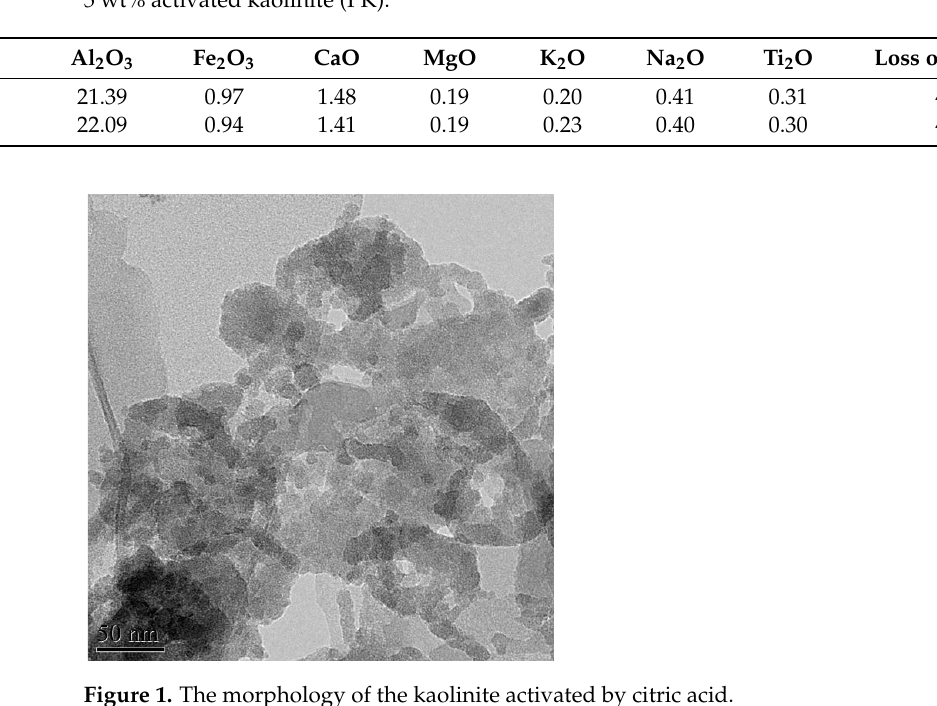
Table 1. Chemical composition (wt%) of porcelain raw kaolinite (P) and raw materials mixed with 5 wt% activated kaolinite (PK).